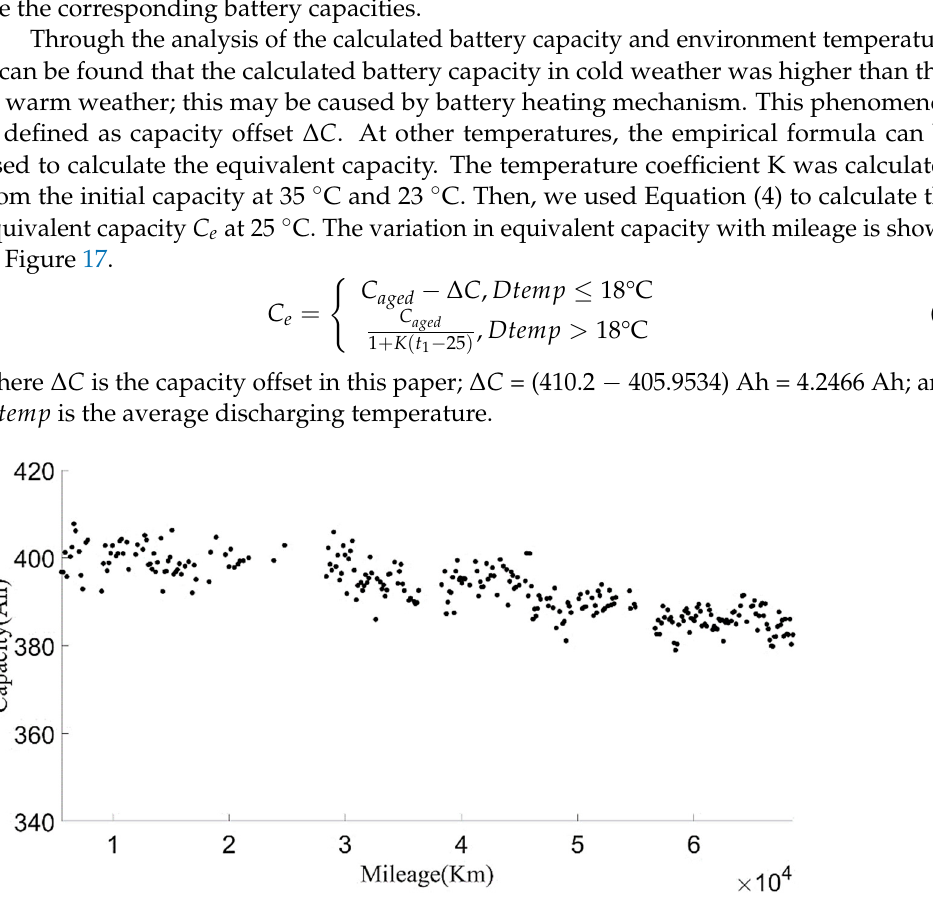
Figure 17. The relationship between the equivalent current capacity (at 25 °C) and the mileage.